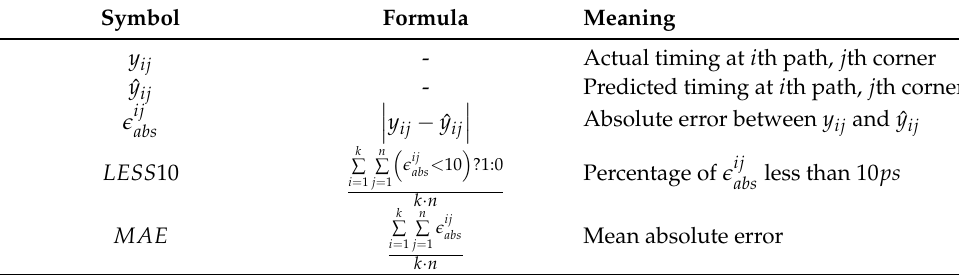
Table 4. Reporting metrics for prediction accuracy